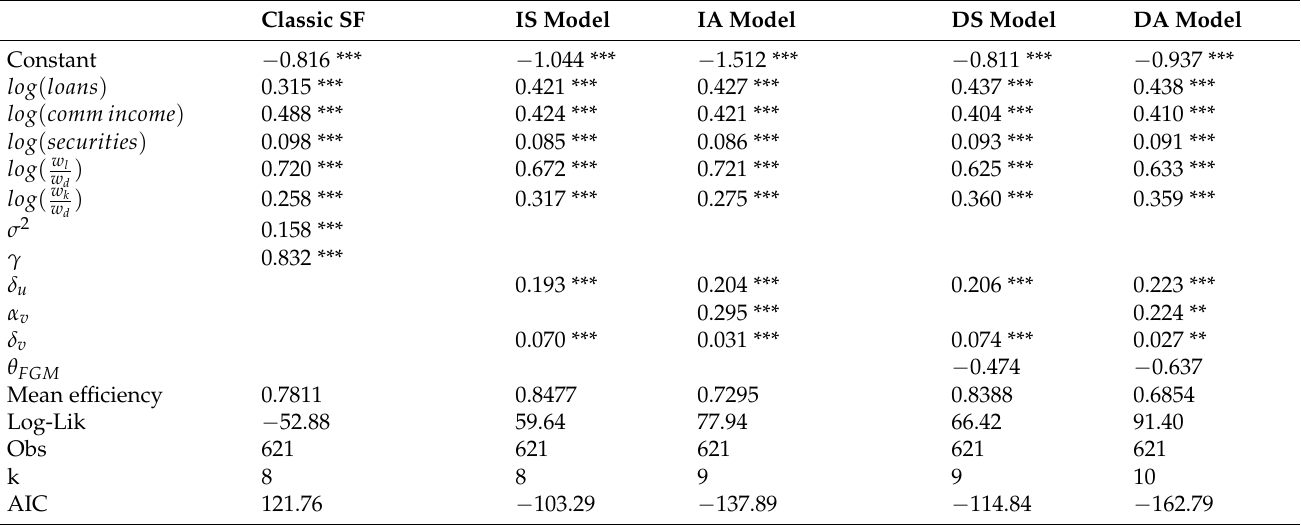
Table 2. Estimated cost frontiers for Italian banks in